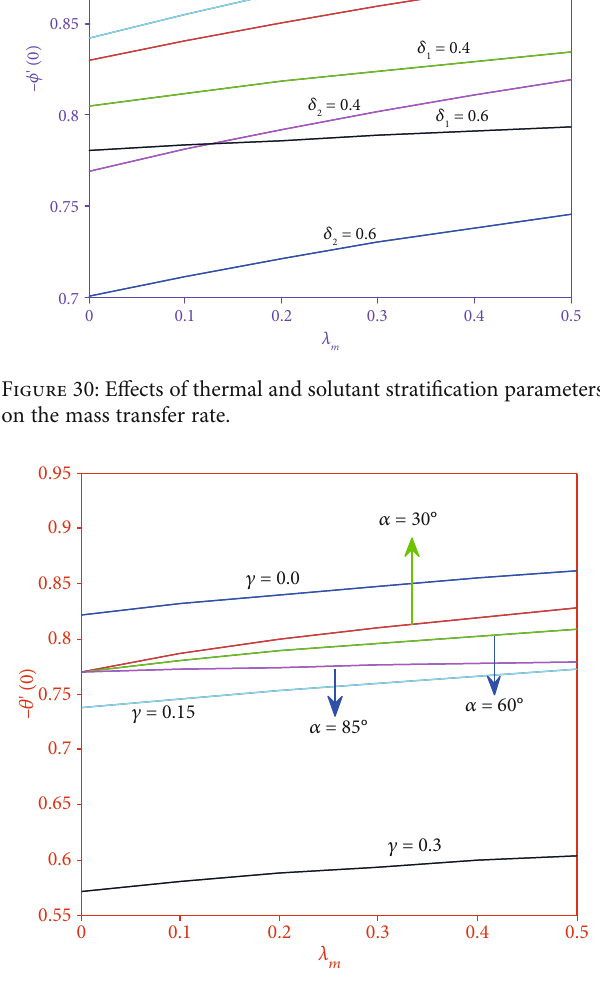
Figure 31: E ff ects of curvature and inclination parameters on the heat transfer